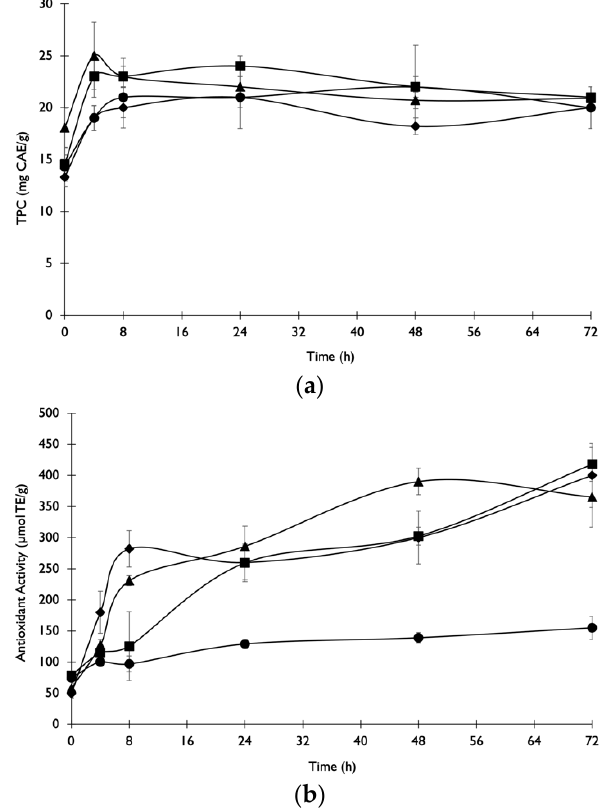
Figure 4. Variation of ( a ) phenolic compounds and ( b ) antioxidant activity after ET of untreated COP using the enzymatic extract with crude extract loads of 0.75 ( ● ), 1.5 ( ■ ), 2.5 ( (cid:117) ) and 5 mL extract/g of substrate ( ▲ ).